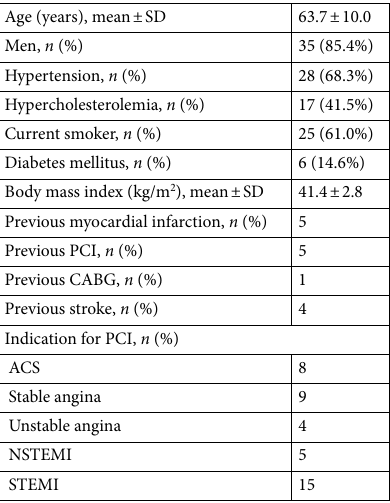
Table 1. Baseline characteristics of study cohort ( n = 41). PCI percutaneous coronary intervention, CABG coronary artery bypass graft, ACS acute coronary syndrome, NSTEMI non-ST segment elevation myocardial infarction, STEMI ST-segment elevation myocardial infarction.